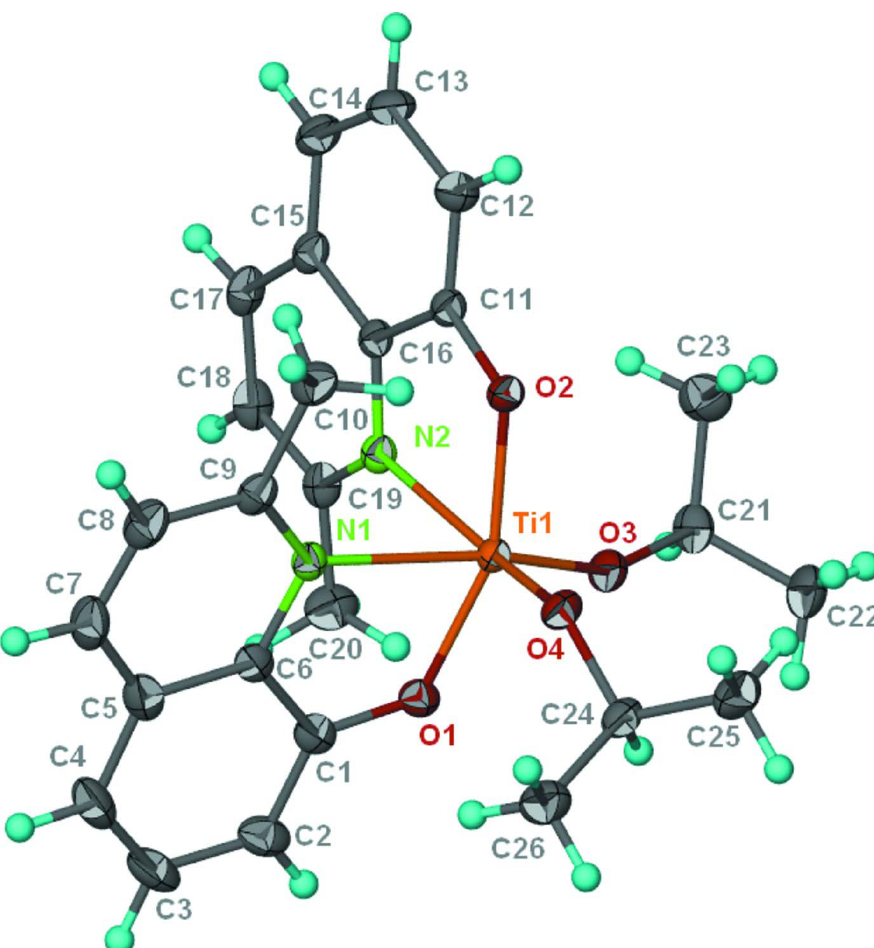
H NO) (C H O) at the 70% probability level showing atom labelling. 10 8 2 3 7 2